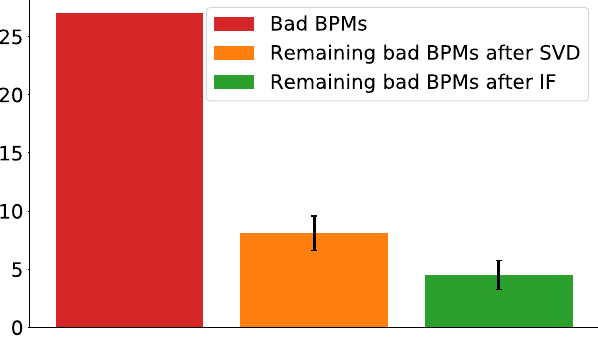
FIG. 9. Averaged results of faulty BPMs detection on 20 simulated measurements using IF contamination factor 0.01 and SVD cut